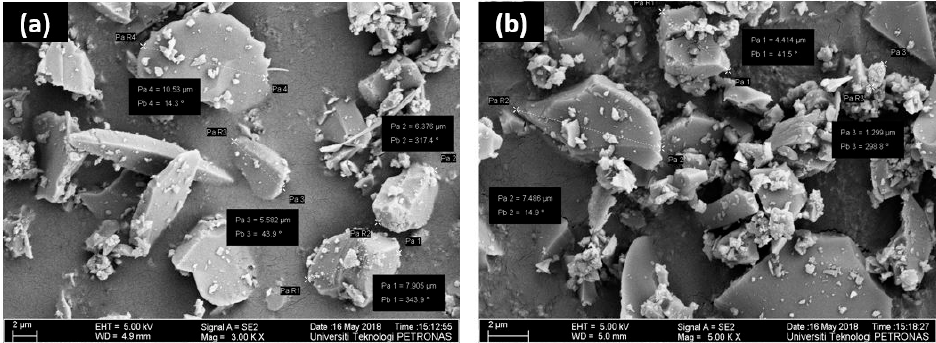
Figure 2. FESEM image of ( a ) pure Sil particles ( b ) IL-modified Sil particles.